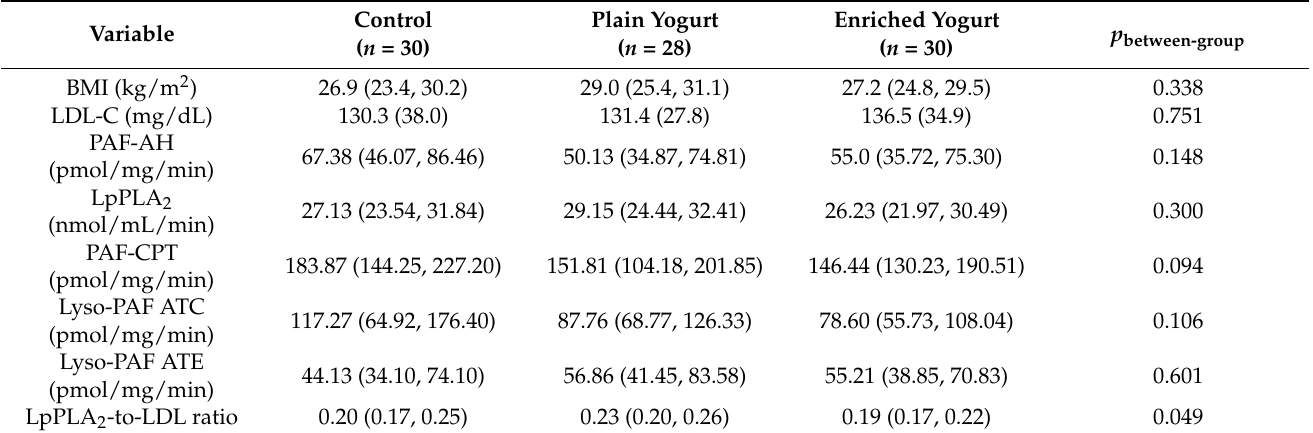
Table 3. Characteristics of the participants during the 8th week of the dietary intervention (ITT analysis).